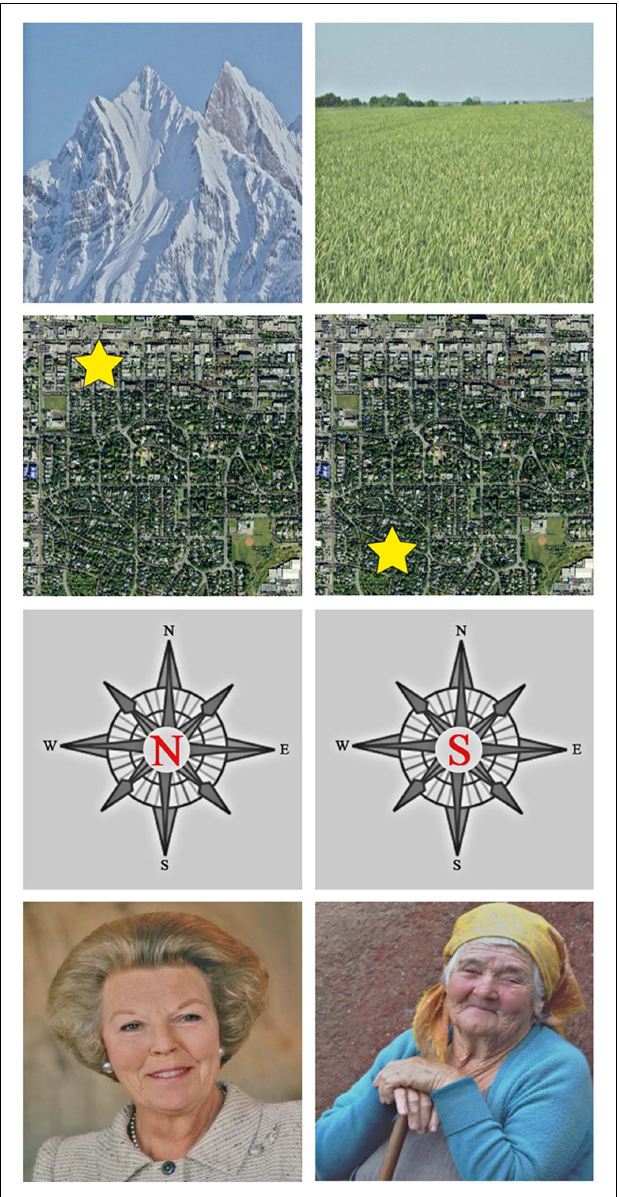
FIGURE 1 | Example stimuli used in the adapted implicit association test. First row: Experiment 1 topography stimuli, with examples of mountainous (left) and level terrain (right). Second row: Experiment 2 cardinal indicator stimuli, with examples of north (left) and south (right) indication.Third row: Experiment 3 cardinal indicator stimuli, with examples of north (left) and south (right) indication. Fourth row: Experiments 1, 2, and 3 social status stimuli, with examples of powerful (left) and average